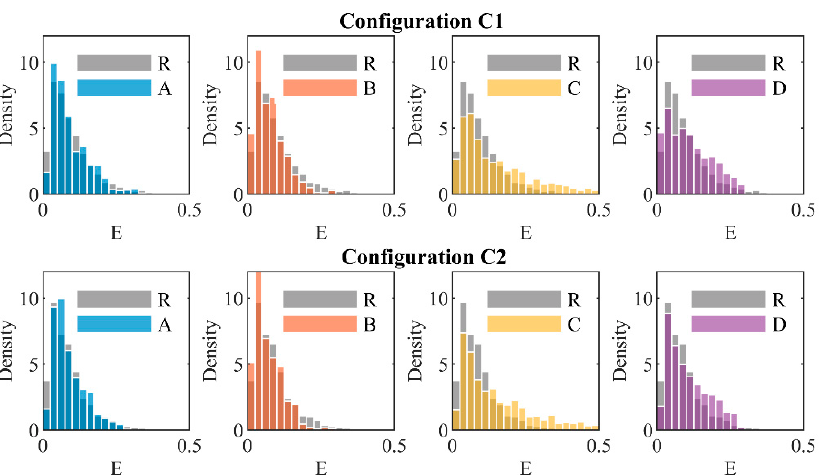
Figure 11. S101 bridge: Histogram plots of the instantaneous values of the interpolation error 𝐸 at sensor 5 for different damage states and sensor subset configurations.